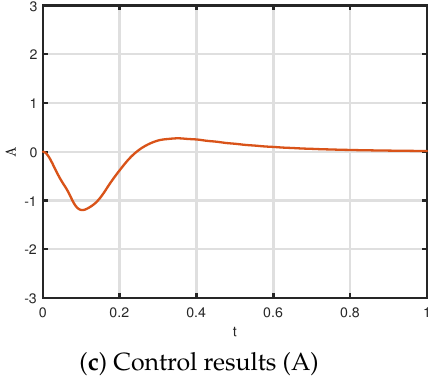
Figure 9. Control effects with initial conditions ( x P = − 0.001, y P =